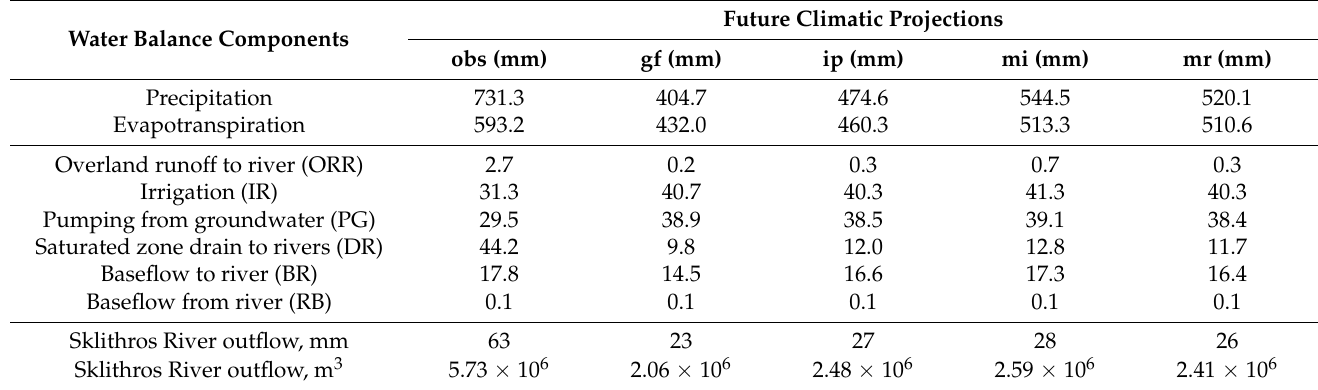
Table 6. Water balance components of sub-basins (9116 ha) upstream the lake Zazari under current (obs) (1 January 2013–3 December 2017) and future (2061–2080) climatic